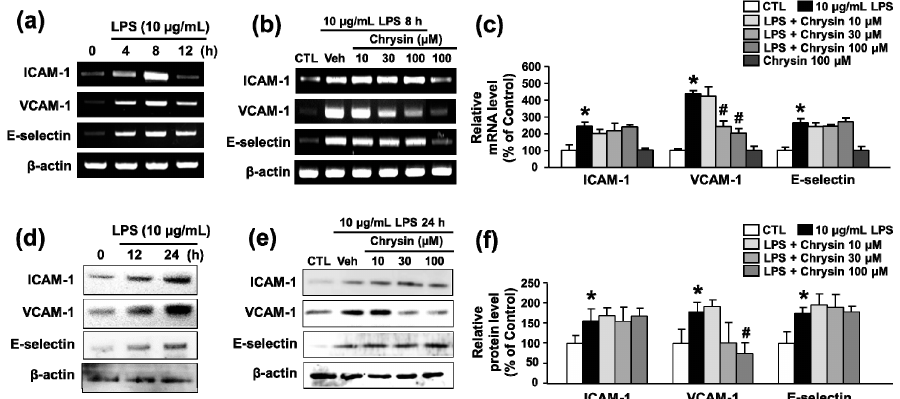
Figure 1. The effect of chrysin on LPS-induced adhesion molecule mRNA and protein expression in bEnd.3 cells. ( a ) RT-PCR of adhesion molecules after 10 µ g/mL LPS treatment. bEnd.3 cells were treated with 10 µ g/mL LPS for 4, 8, or 12 h; ( b ) RT-PCR of adhesion molecules after LPS and chrysin treatment. Cells were pretreated with chrysin (10–100 μ M) for 30 min and co-stimulated with 10 μ g/mL LPS for 8 h; ( c ) the levels of ICAM-1, VCAM-1, and E-selectin mRNA were evaluated by RT-PCR and quantified by densitometry; ( d ) Western blotting of adhesion molecules after 10 μ g/mL LPS treatment. bEnd.3 cells were treated with 10 μ g/mL LPS for 12 or 24 h; ( e ) Western blotting of adhesion molecules after LPS and chrysin treatment. Cell were pretreated with chrysin (10–100 μ M) for 30 min and co-stimulated with 10 μ g/mL LPS for 24 h; and ( f ) the levels of ICAM-1, VCAM-1, and E-selectin protein were evaluated by Western blotting and quantified by densitometry. β -actin was used for normalization. Mean ± SEM, * p < 0.05 vs. control and # p < 0.05 vs. 10 μ g/mL LPS alone, n = 3.